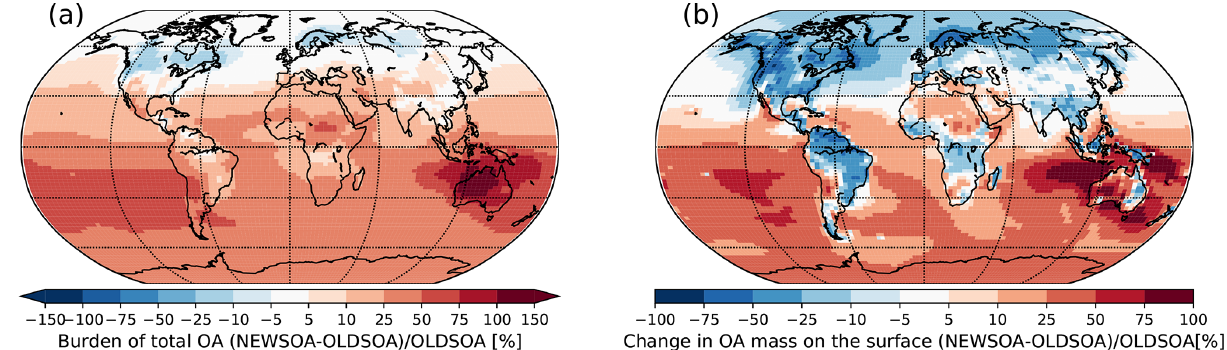
Figure 12. Annual mean difference between NEWSOA and OLDSOA in (a) OA mass burden in the atmosphere and (b) OA mass concen- tration at the